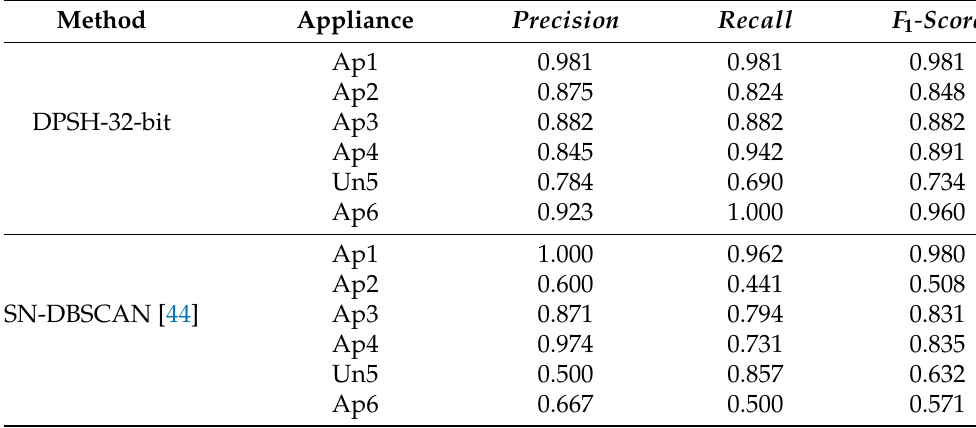
Table 6. The disaggregation performance on PLAID with unidentified